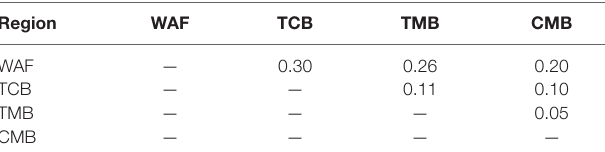
TABle 1 | Pairwise differentiation between isolates from four regions, estimated using the F ST values.